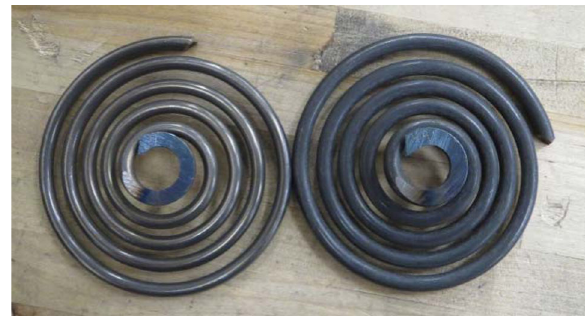
FIG. 11. The two types of springs used in the spring units. The weaker type is on the left and the stronger on the right.